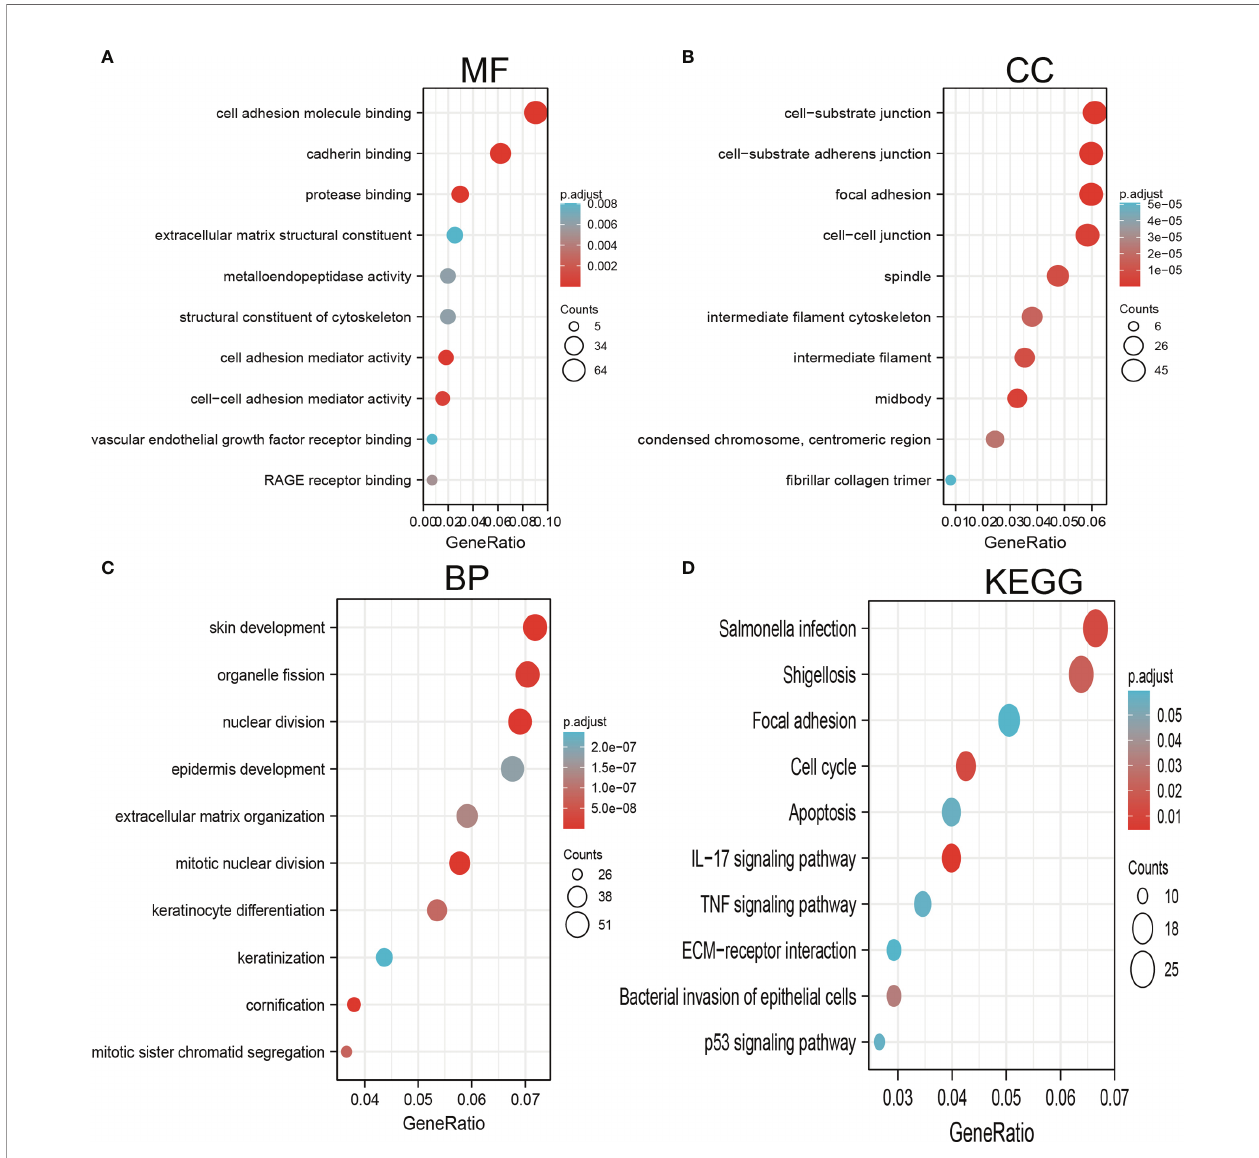
FIGURE 6 | GO and KEGG enrichment analysis for AC068228.1. (A) Top 10 enrichment terms in MF categories in LUAD. (B) Top 10 enrichment terms in CC categories in LUAD. (C) Top 10 enrichment terms in BP categories in LUAD. (D) Top 10 KEGG enrichment pathways in